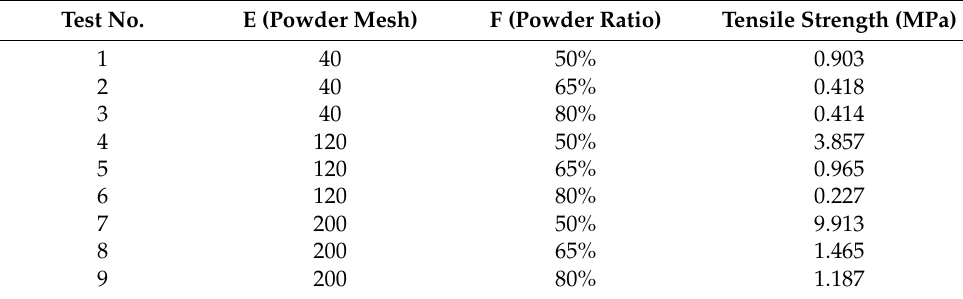
Table 7. Results of tensile strength